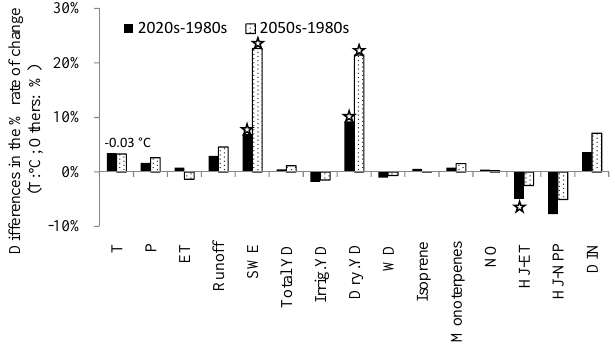
Fig. 3. Differences in the percentage change between BC and NBC climate data and the simulated outputs driven by bias-corrected (BC) and non-bias-corrected (NBC) climate. They are calculated as [ 1 BC 20s - 80s (%) − 1 NBC 20s - 80s (%)] for the change between the 1980s and 2020s and [ 1 BC 50s - 80s (%) − 1 NBC 50s - 80s (%)] for the change between the 1980s and 2050s. For T , it is total differences in degrees Celsius, i.e., ( 1 BC 20s - 80s − 1 NBC 20s - 80s ) for the change between the 1980s and 2020s, and ( 1 BC 50s - 80s − 1 NBC 50s - 80s ) for the change between the 1980s and 2050s. T : annual mean tem- perature; P : average annual precipitation; ET: average annual evap- otranspiration; Runoff: total runoff; SWE: snowpack water equiva- lent on 1 April; Total YD: total yield from all croplands; Irrig. YD: yield from irrigated cropland; Dry YD: yield from dryland (non- irrigated cropland); WD: total irrigation water demand over irri- gated cropland, HJ-ET: RHESSys modeled ET over HJ-Andrews watershed; HJ-NPP: RHESSys modeled net primary production (NPP) over HJ-Andrews watershed; DIN: NEWS modeled dis- solved inorganic nitrogen yield over the Columbia River basin. The small stars under or above each column represent p value < 0 . 05 for the Student t test of differences between BC anomalies and NBC anomalies during the period of the 2020s and 2050s,